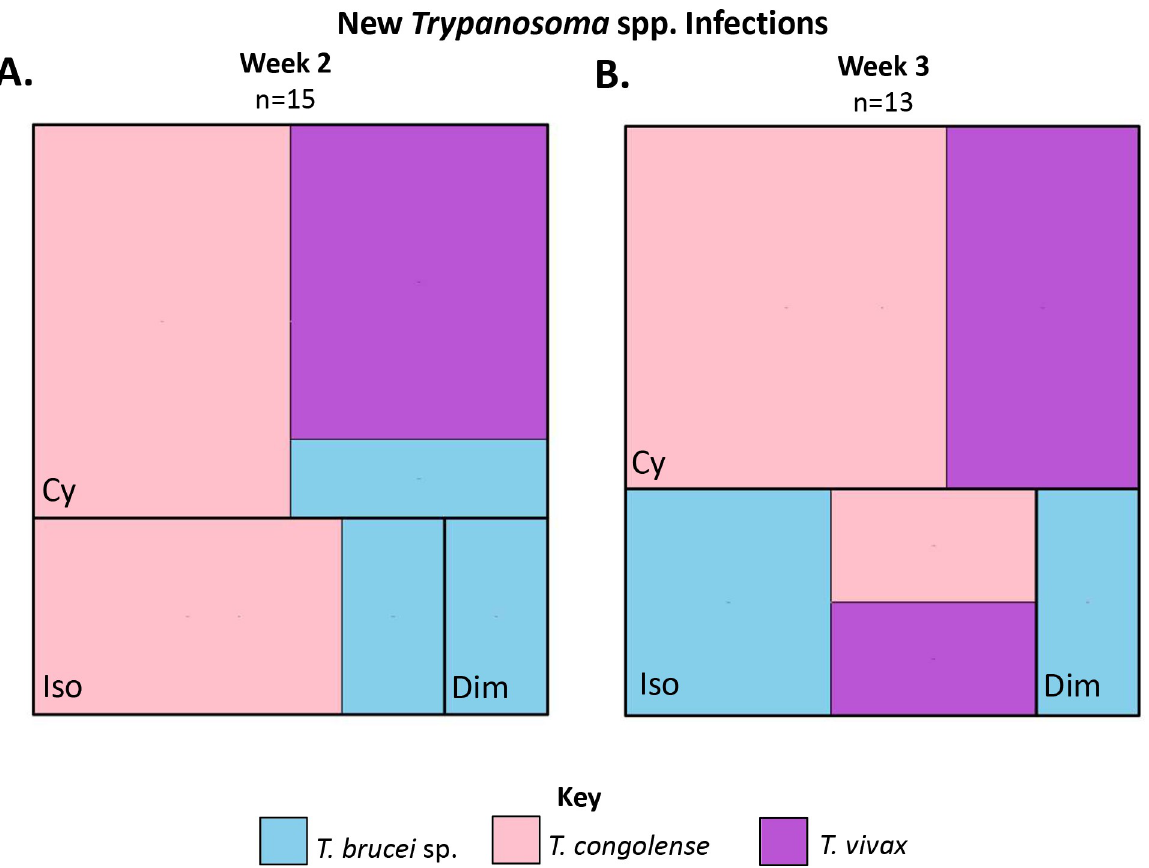
Fig 7. Tree maps illustrating the number of new PCR positive animals during the study period within the whole study population (n = 247). The new positives are subdivided by trypanocidal treatment (Cy = melarsomine dihydrochloride, Dim = diminazene, Iso = isometamidium) and Trypanosoma sp ( T . congolense = pink, T . brucei sp. = pale blue, T . vivax = purple). A. Tree map illustrating new PCR positives during week 2 (n = 15). B. Tree map illustrating new PCR positives during week 3 (n =